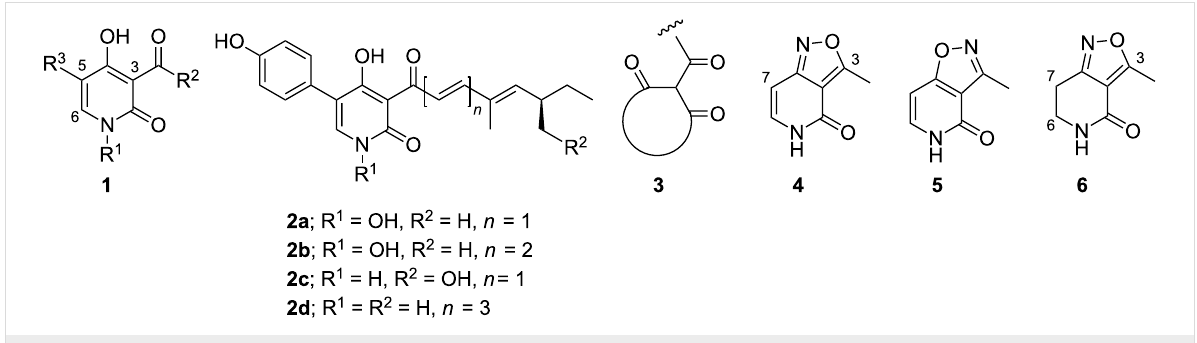
Figure 1: The 3-acyl-4-hydroxypyridin-2-one motif, example natural products and the isoxazolopyridone scaffolds.